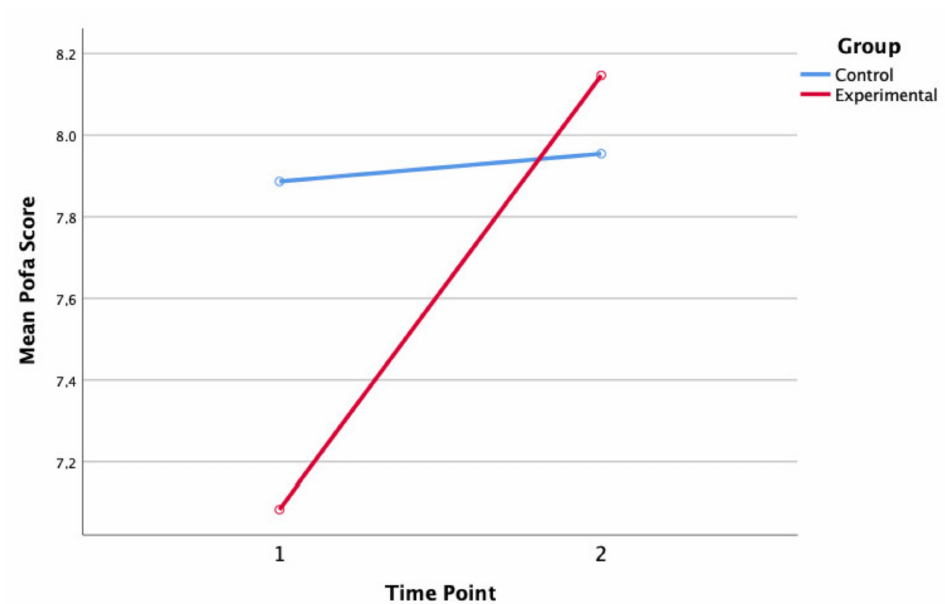
Figure 1. Mean Pictures of Facial Affect (POFA) for experimental and control group children at baseline (1) and post-intervention follow-up